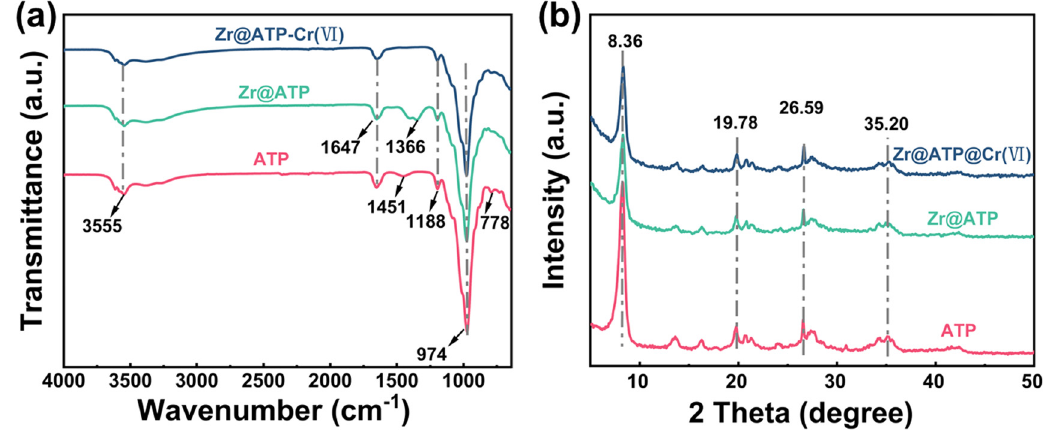
Figure 4: The ( a ) FT - IR spectra and ( b ) XRD patterns for ATP, Zr@ATP, and Zr@ATP after adsorbing Cr ( VI )